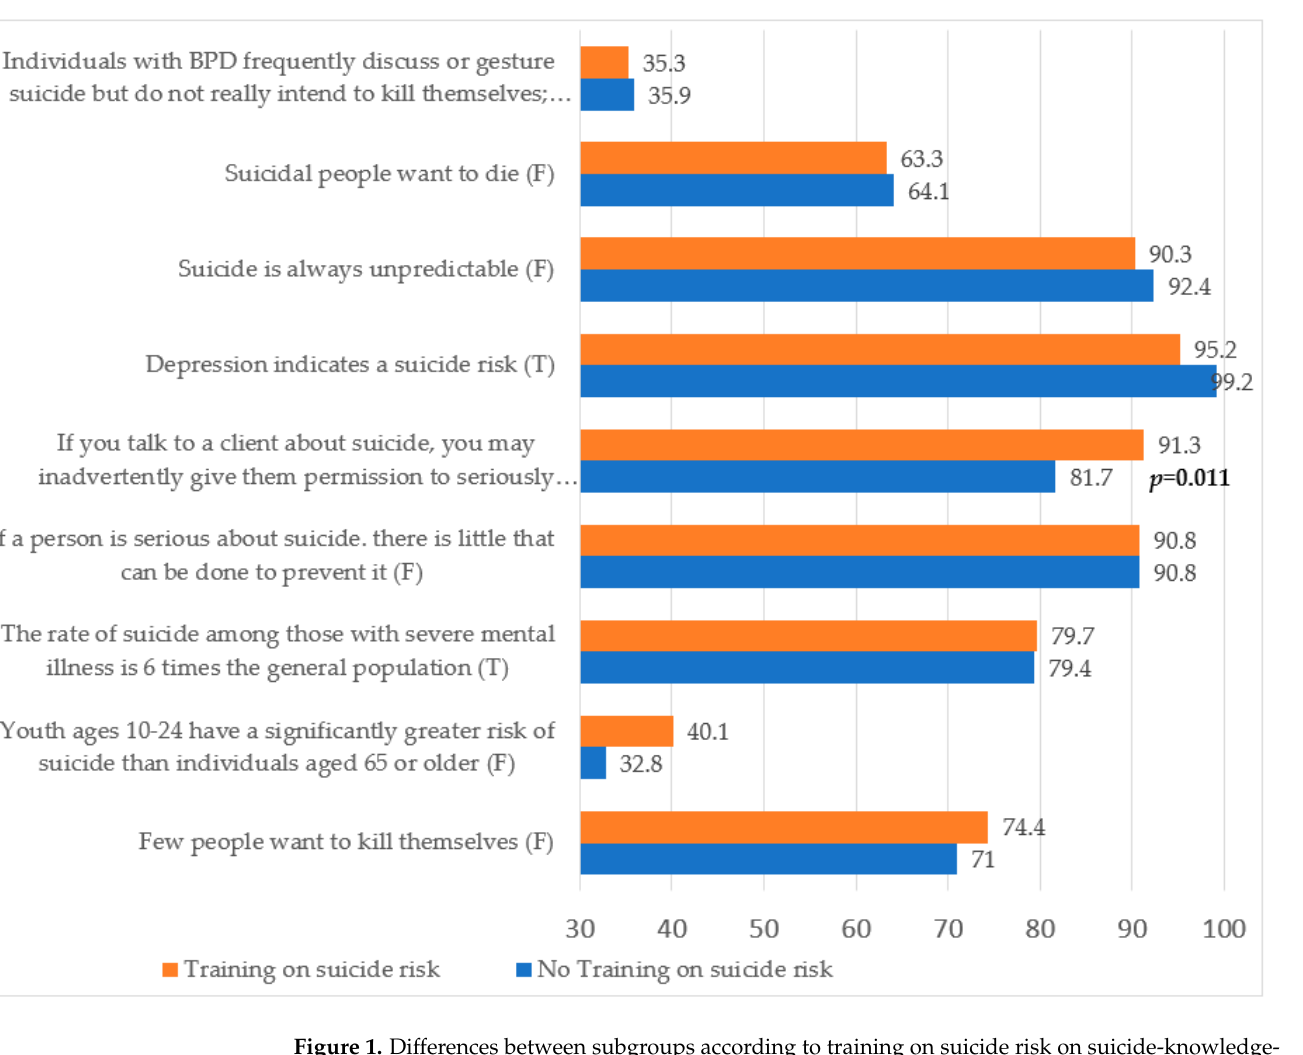
Figure 1. Differences between subgroups according to training on suicide risk on suicide-knowledge-subscale item. (BPD = Borderline Personality Disorders)